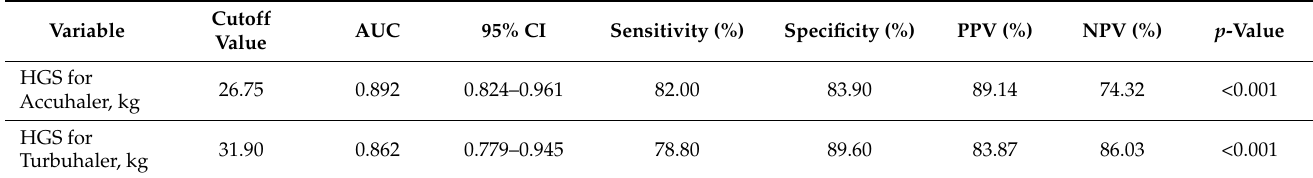
Figure 4. The receiver operating characteristic (ROC) plot of handgrip strength (HGS) and peak inspiratory flow rate (PIFR) for Accuhaler. The best cutoff value of HGS for Accuhaler is 26.8 kg, with the area under the ROC curve of 0.892 (95% CI; 0.824–0.961, p <0.001), 82% sensitivity, and 84% specificity.